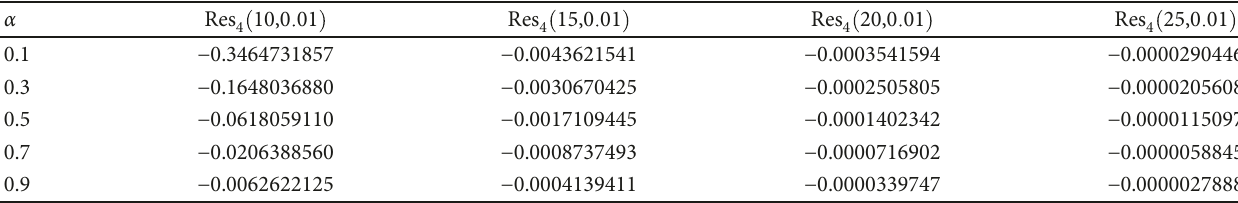
Table 3: Comparison the 4th residual function for di ff erent α and x at t = 0 01